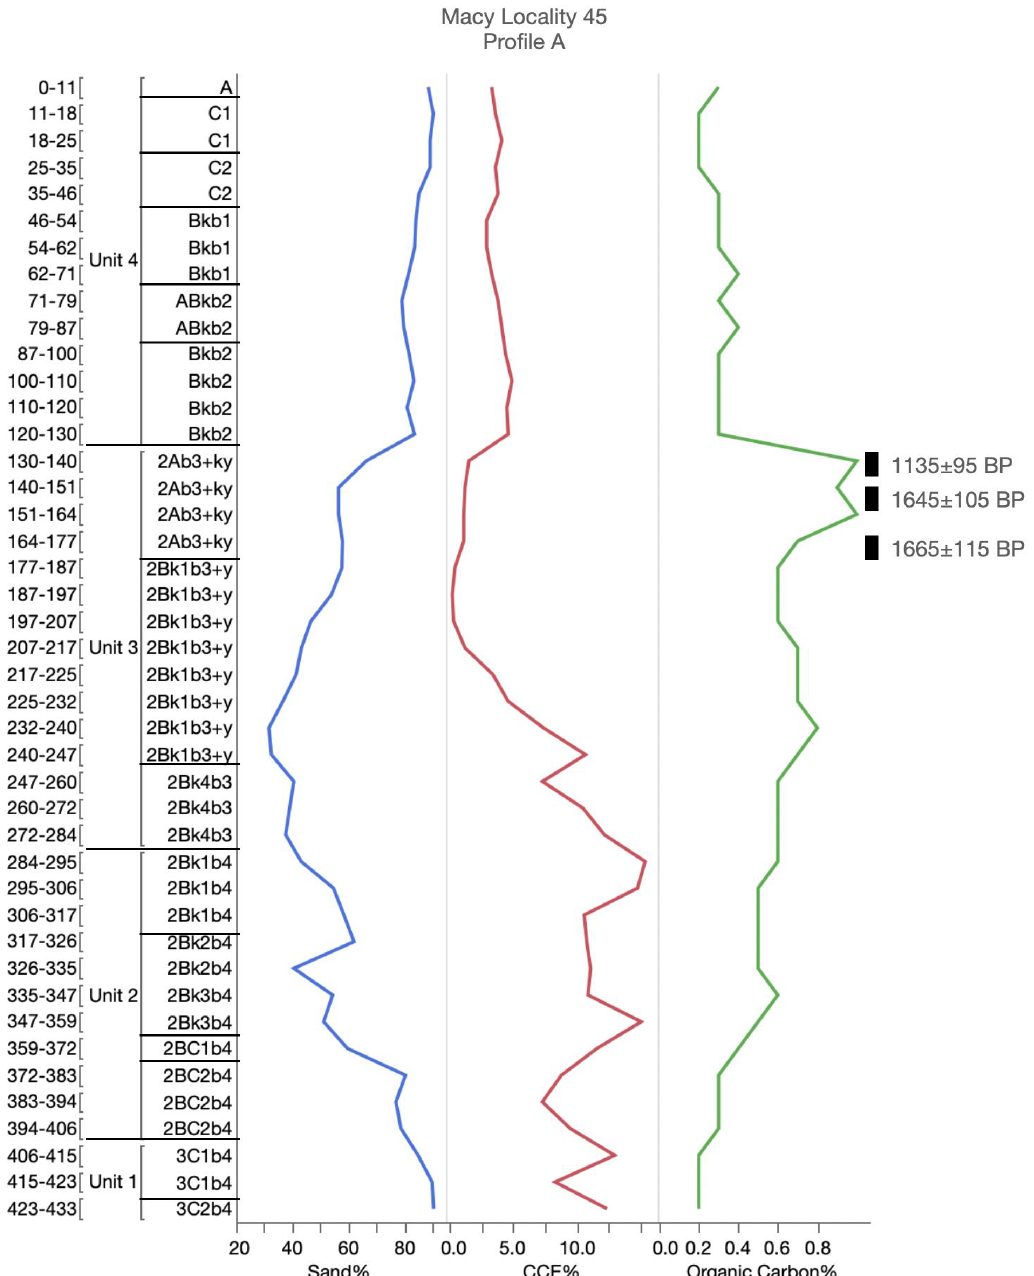
Figure A5. Accepted radiocarbon ages and soil and sediment analysis at Macy Locality 45, Profile A—Post research area, northwest, Texas. CCE = calcium carbonate equivalence.